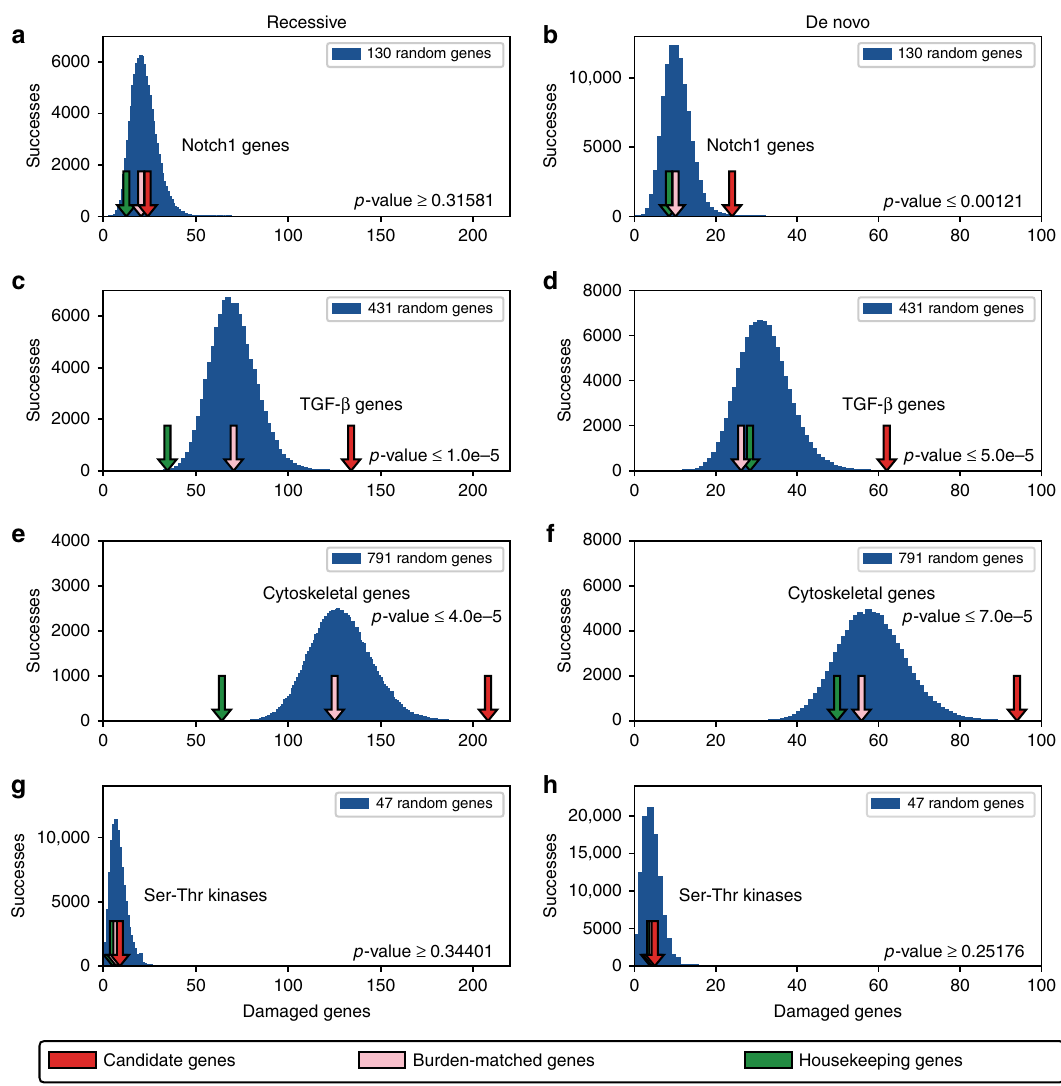
Fig. 4 Enrichment pro fi les for additional genes and gene pathways. Several additional pathways implicated in congenital heart disease were tested for enrichment in damaging recessive genotypes and de novo mutations. a , b The Notch signaling pathway is enriched for de novo mutations ( p value < 0.0012) but is not enriched for damaging recessive genotypes. c – f Genes involved in TGF- β signaling and non-ciliary cytoskeletal genes are moderately enriched in damaging recessive and de novo genotypes. g , h In contrast, receptor serine-threonine kinases show no enrichment for either damaging de novo or recessive genotypes. All p values are obtained by emperical permutation Table 1 Relative enrichment of damaging genotypes